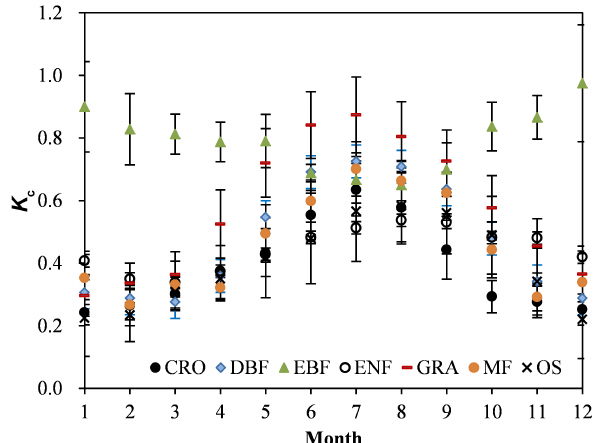
Figure 2. The variation of K c for the different IGBP codes. The error bars are standard errors among different sites. The seven veg- etation covers are open shrubland (OS), cropland (CRO), grassland (GRA), deciduous broad leaf forest (DBF), evergreen needle leaf forest (ENF), evergreen broad leaf forest (EBF), and mixed forest (MF). For sites in the Southern Hemisphere, July data were plotted as in